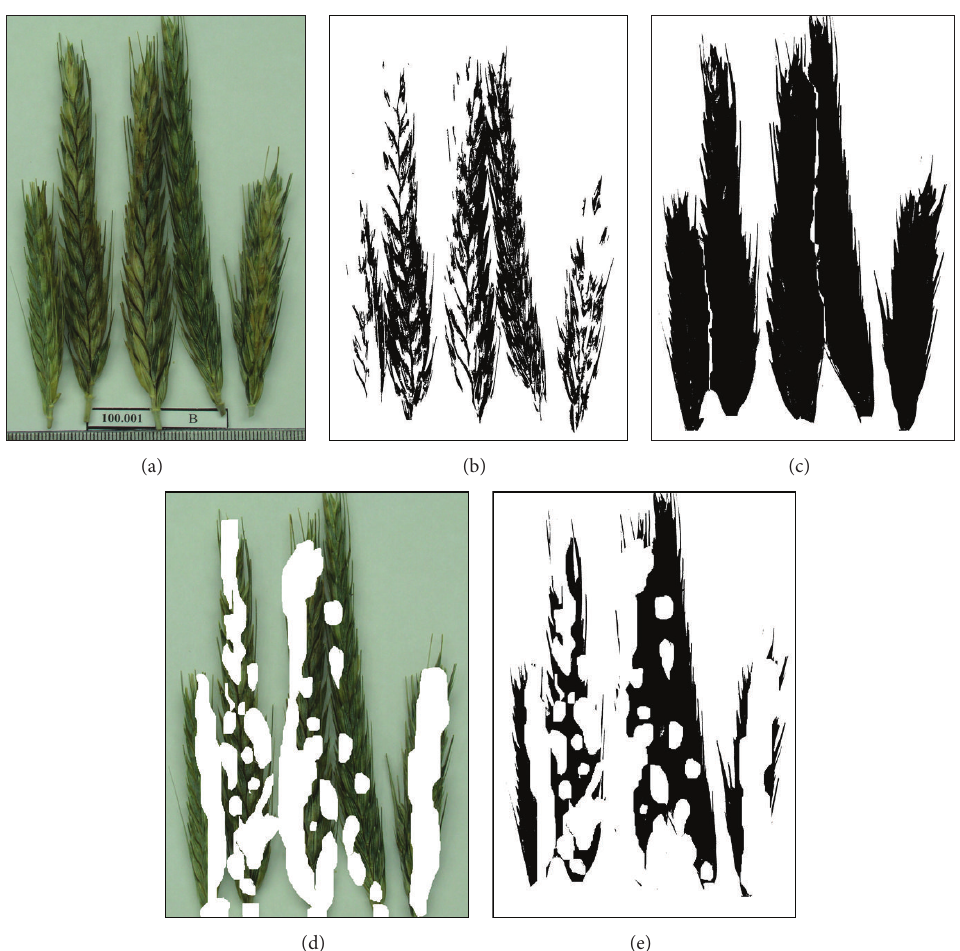
Figure 1: Assessment of blast severity on spikes of the BRS 203 triticale cultivar by digital image analysis. (a) Symptomatic spikes. (b) Selection of symptomatic areas by image segmentation (SIS method). (c) Total spike areas considered. (d) Selection of symptomatic areas with mouse cursor (SCU method). (e) Application of binary pattern of colors on the SCU method (the white area is diseased; the black is